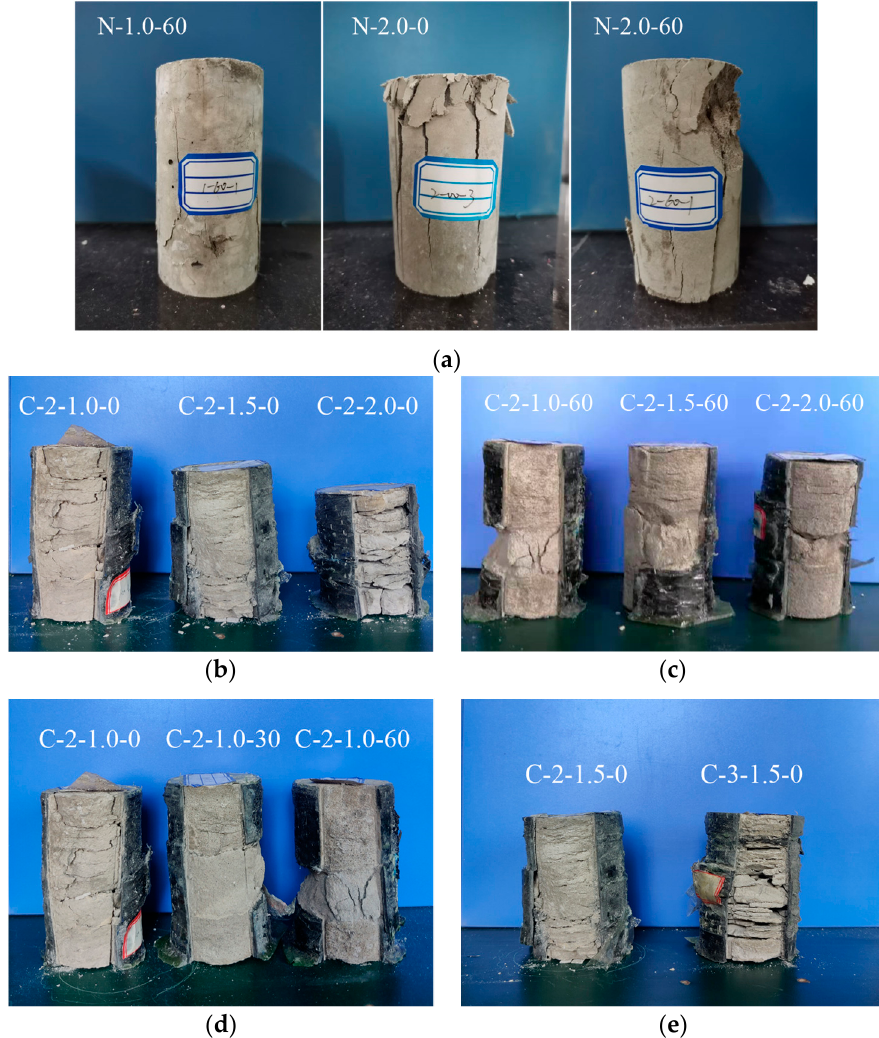
Figure 8. Typical failure modes of unconfined and confined cementitious grout material in SBM specimens: ( a ) Series R; ( b ) Series 1; ( c ) Series 2; ( d ) Series 3; ( e ) Series 4. R-specimens and CSBM specimens are all dry after curing in the laboratory environment for seven days.